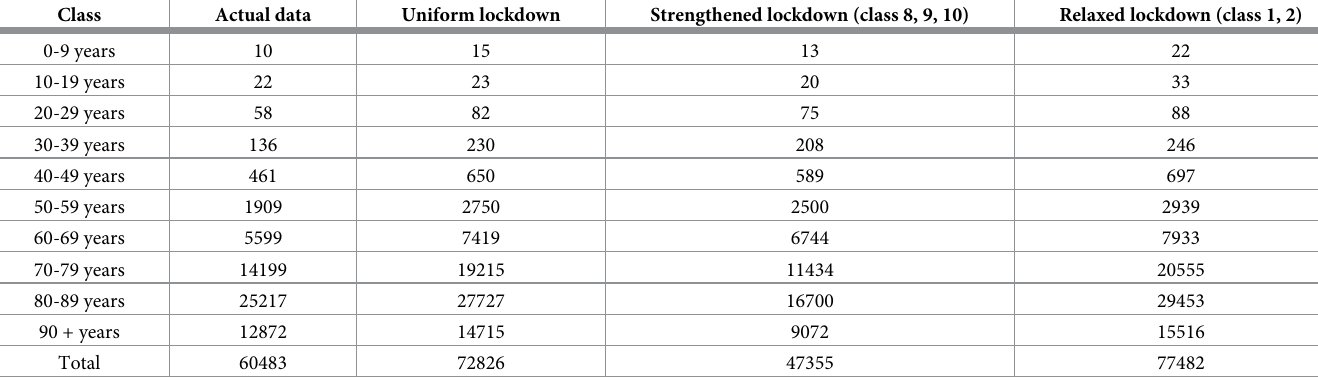
Table 2. Per-class cumulative number of deaths for the time period from Nov. 5, 2020 to March 20,